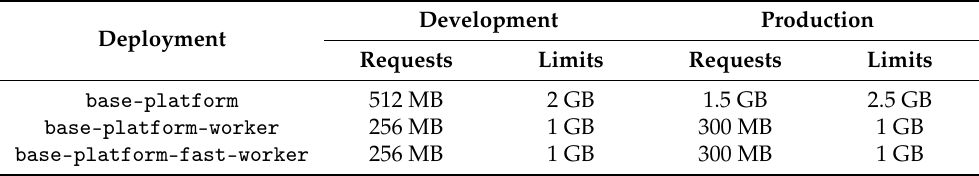
Table 1. Resource allocation per microservice deployment in the managed Kubernetes